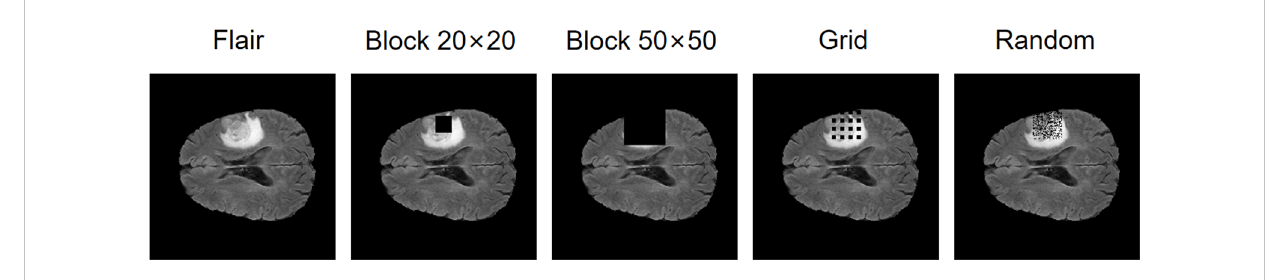
FIGURE 7 The effect of masking strategies that we design.